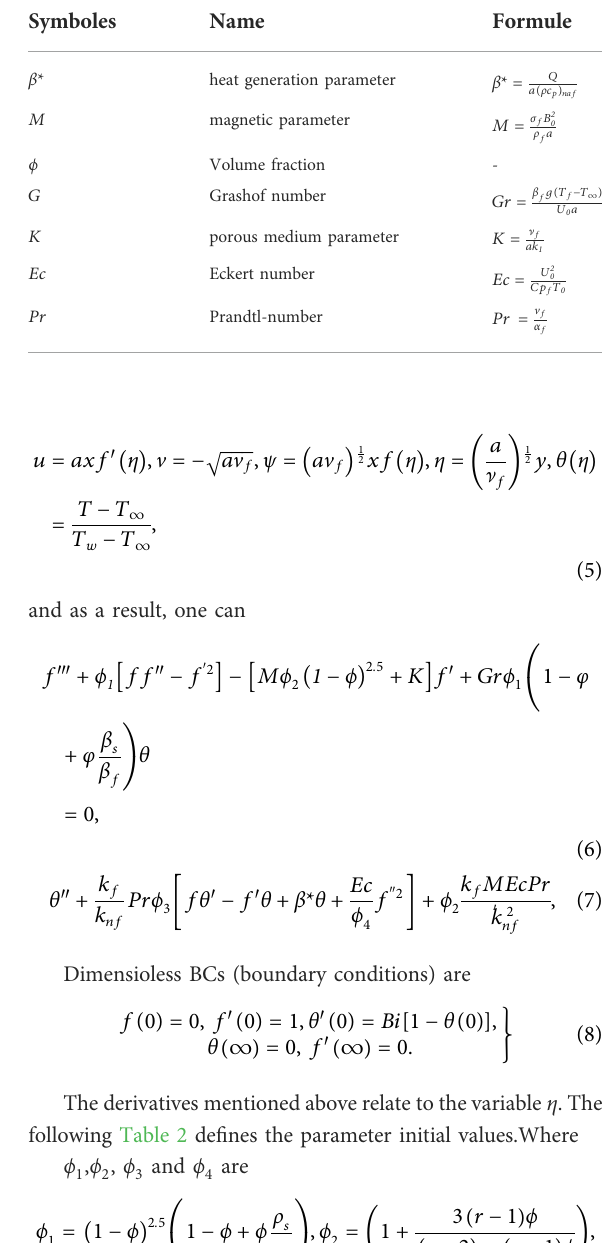
TABLE 2 Overview of the ingrained control